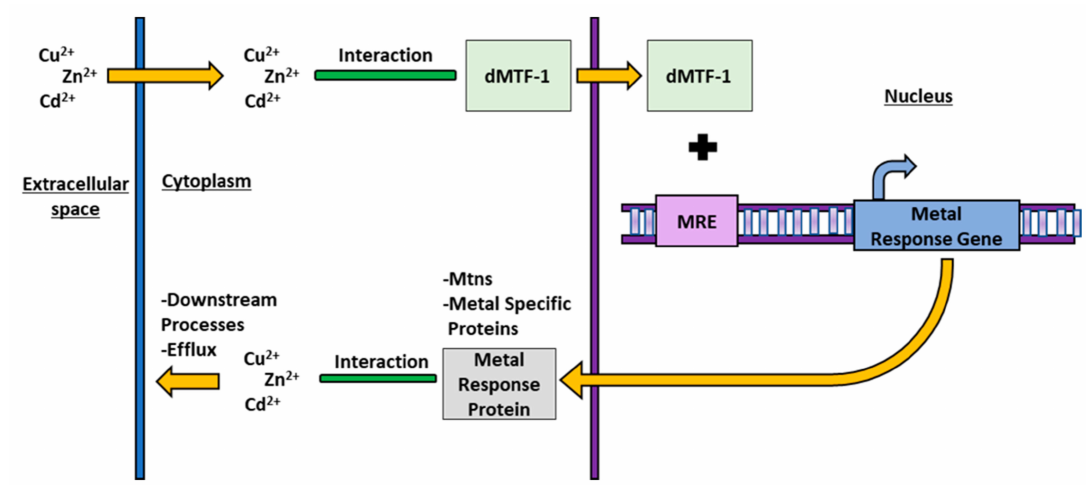
Figure 1. A diagram of the D. melanogaster general metal response system responds to both essential and non-essential metal stress. All figures follow the same pattern and colour scheme: the movement of metal ions is represented by orange arrows, interaction between metals and proteins is represented by green bars/arrows, transcription factor proteins are coloured light green, response element proteins are light purple, DNA is purple, genes are dark blue, and other proteins are gray. Underlined labels denote areas inside the cell, organelles, or space outside of the